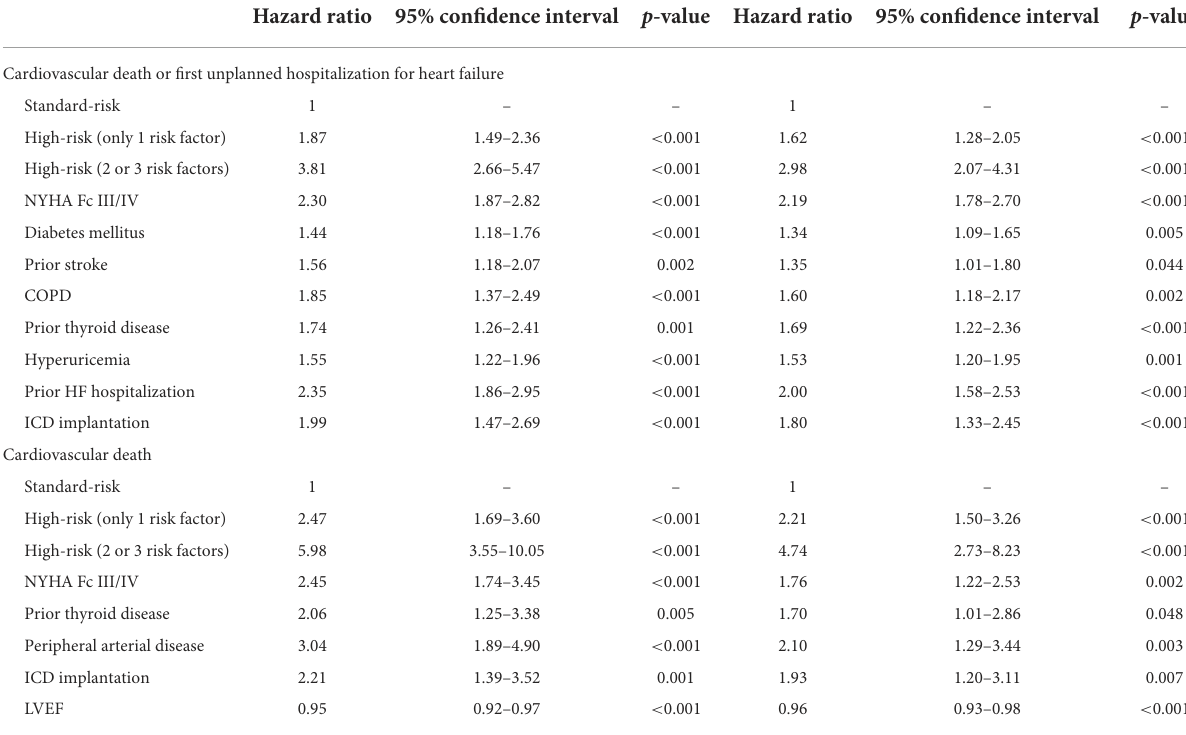
TABLE 3 Multivariate analysis for high-risk vs. standard-risk patients and clinical outcomes. Univariate